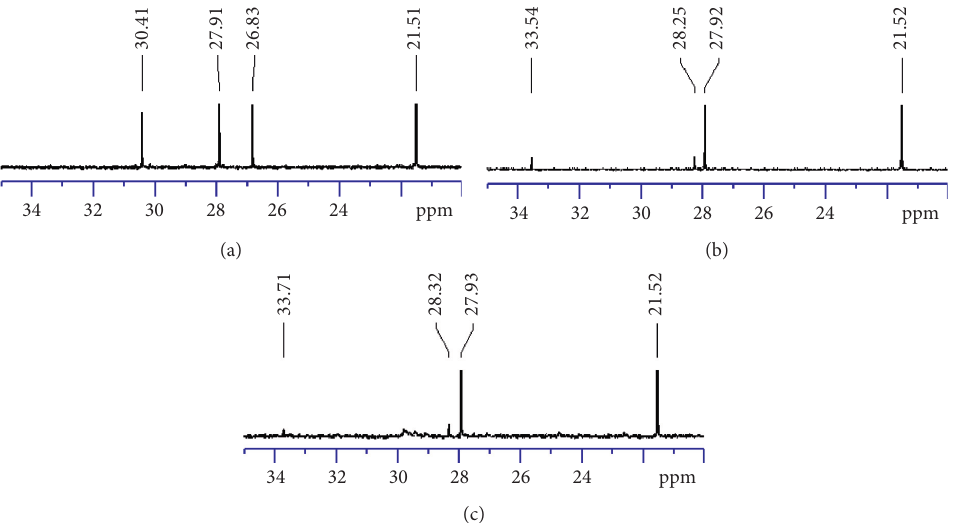
Figure 5: The partially enlarged 13C-NMR of GBL spiked into 0.2% aqueous solution of formic acid (a), GBL spiked into soda water (b), and GBL spiked into coffee drink